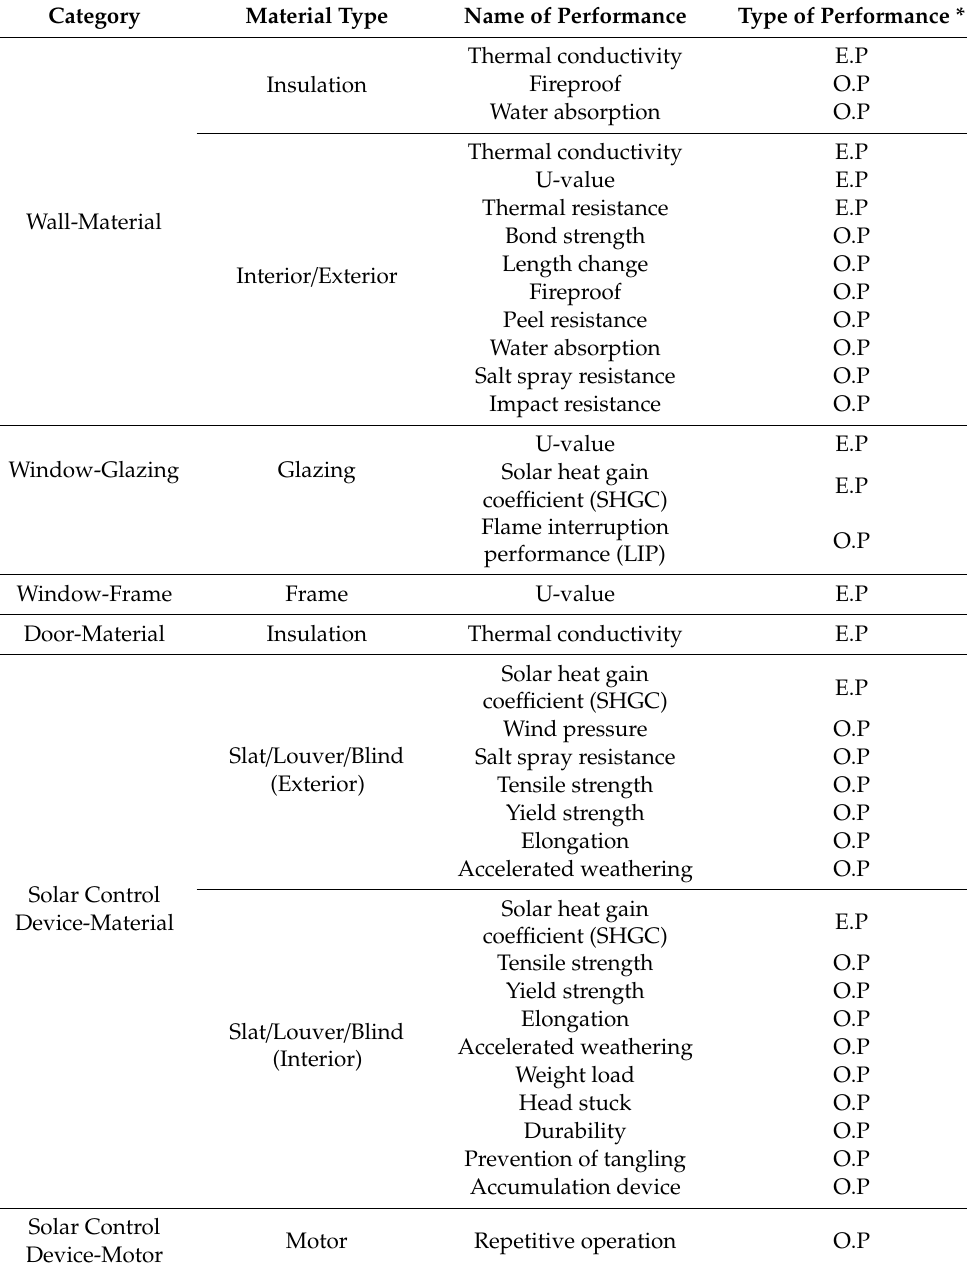
Table 2. Material performance